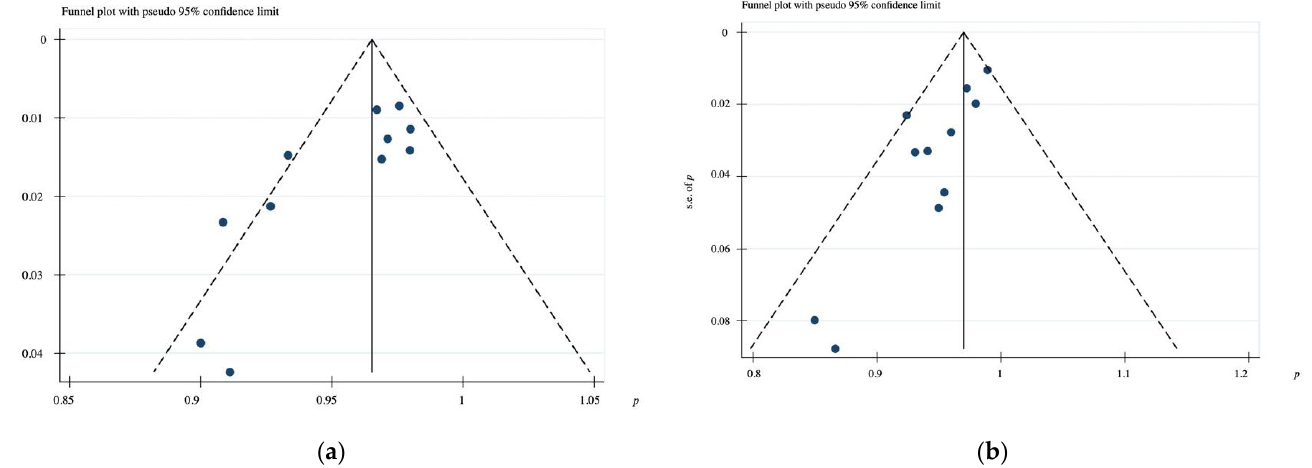
Figure 4. Funnel plot: ( a ) Implant survival rate after 1–6-year follow-up; ( b ) Prosthesis survival rate after 1–6-year follow-up.